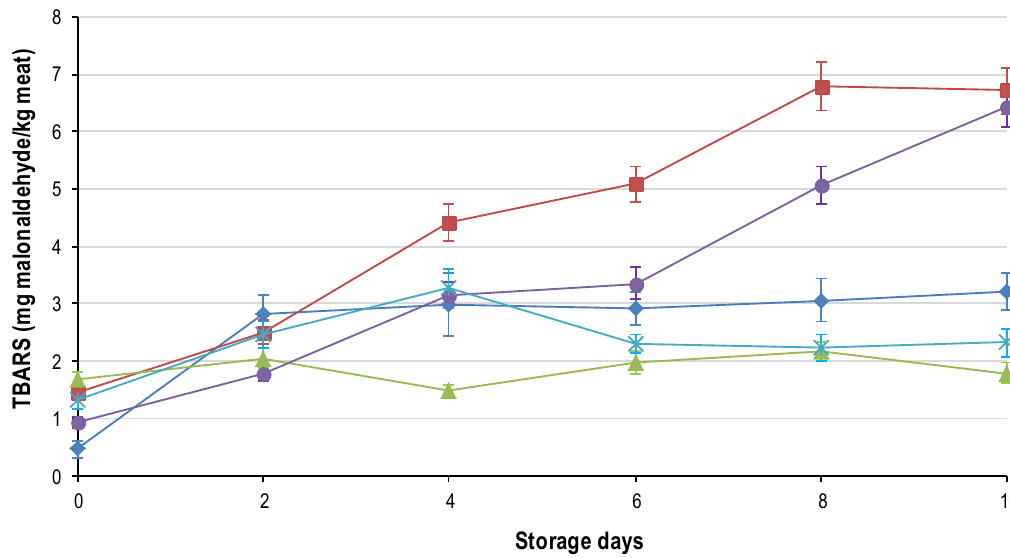
Storage days Storage days Figure 2. Average cooking loss (±std. error) for the five characteristic freezing rates: FR_1h (  ); FR_2h Figure 2. Average cooking loss (±std. error) for the five characteristic freezing rates: FR_1h (  ); FR_2h Figure 2. Average cooking loss (±std. error) for the five characteristic freezing rates: FR_1h (  ); FR_2h Figure 6. Average 2-thiobarbituric acid (TBARS, ± std. error) for the five characteristic freezing rates: Figure 6. Average 2-thiobarbituric acid (TBARS, ±std. error) for the five characteristic freezing rates: (  ); FR_4h (  ); FR_8h (  ) and FR_24h (  ) over the 10-day shelf-life trial at ±4 °C. (  ); FR_4h (  ); FR_8h (  ) and FR_24h (  ) over the 10-day shelf-life trial at ±4 °C. (  ); FR_4h (  ); FR_8h (  ) and FR_24h (  ) over the 10-day shelf-life trial at ±4 °C. FR_1h ( (cid:7) ); FR_2h ( (cid:4) ); FR_4h ( ) over the 10-day shelf-life trial at ± 4 ◦ FR_1h (  ); FR_2h (  ); FR_4h (  ); FR_8h (  ) and FR_24h (  ) over the 10-day shelf-life trial at ±4 °C.